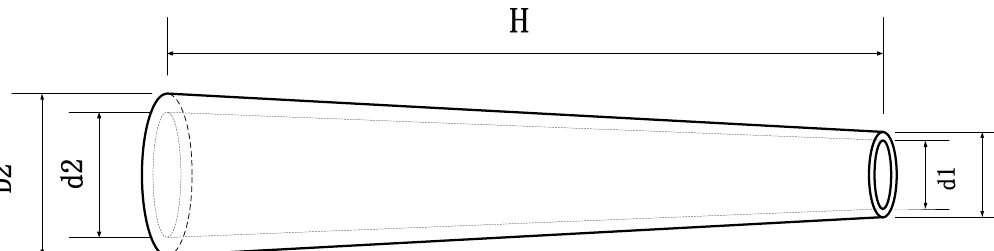
Figure 8. Schematic of tower structure.